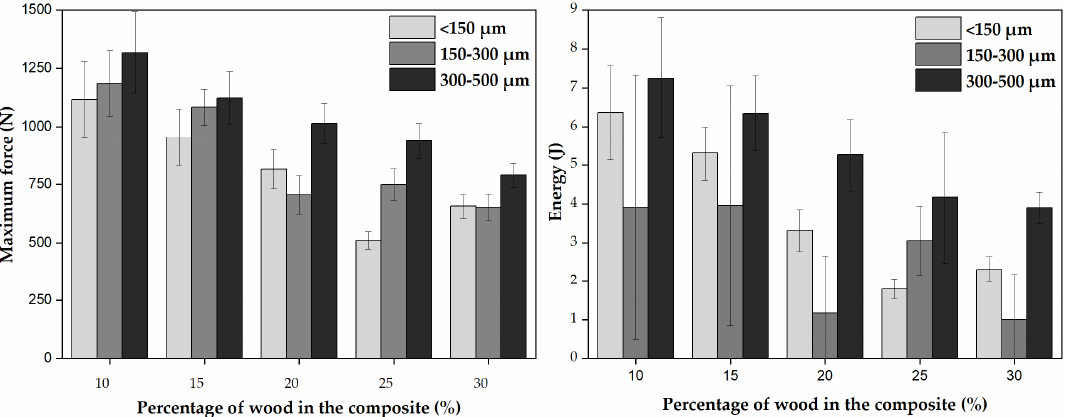
Figure 13. Effect of wood content and granulometry on the mechanical impact properties of MDPE/wood parts, namely, maximum force and energy to maximum force. Table 7. One-way ANOVA for comparison of the population means regarding the maximum force.